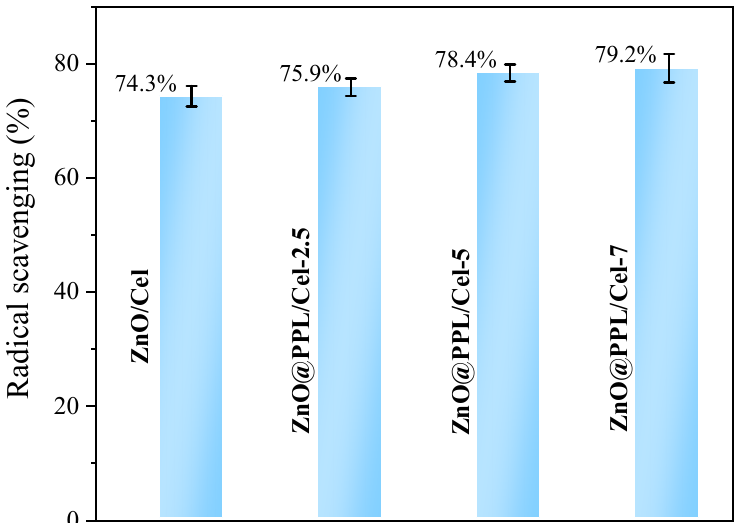
Figure 7. DPPH radical scavenging activity of ZnO/Cel and various samples of ZnO@PPL/Cel. In active food package materials, antibacterial performance is very important. In our work, Gram-negative Escherichia coli ( E. coli ) and Gram-positive Staphylococcus aureus ( S. aureus ) were used to evaluate the antibacterial behavior of samples by the inhibition zone method [50]. It can be seen from Figure 8 that PPL, PPL–11 and PPL–11–H have a similar and modest antibacterial activity toward both E. coli and S. aureus. However, both ZnO/Cel and ZnO@PPL/Cel show high antibacterial activity. The diameter of the inhibition zones of ZnO/Cel against E. coli and S. aureus were 18.9 and 20.9 mm, respec- tively. When the sample diameter (15 mm) is subtracted, the widths of inhibition zones were 3.9 ( E. coli ) and 5.9 ( S. aureus ) mm. When coupled with PPL, ZnO@PPL/Cel samples had much better performance than ZnO/Cel: the inhibition zones for E. coli and S. aureus increased to 24.9 mm and 31.2 mm, respectively. The calculated width of inhibition zones was 5.9 and 8.1 for E. coli and S. aureus , respectively, which have been improved 150% and 137% compared to those of ZnO/Cel. These results are evidence that PPL in the composite would enhance the antibacterial activity greatly.